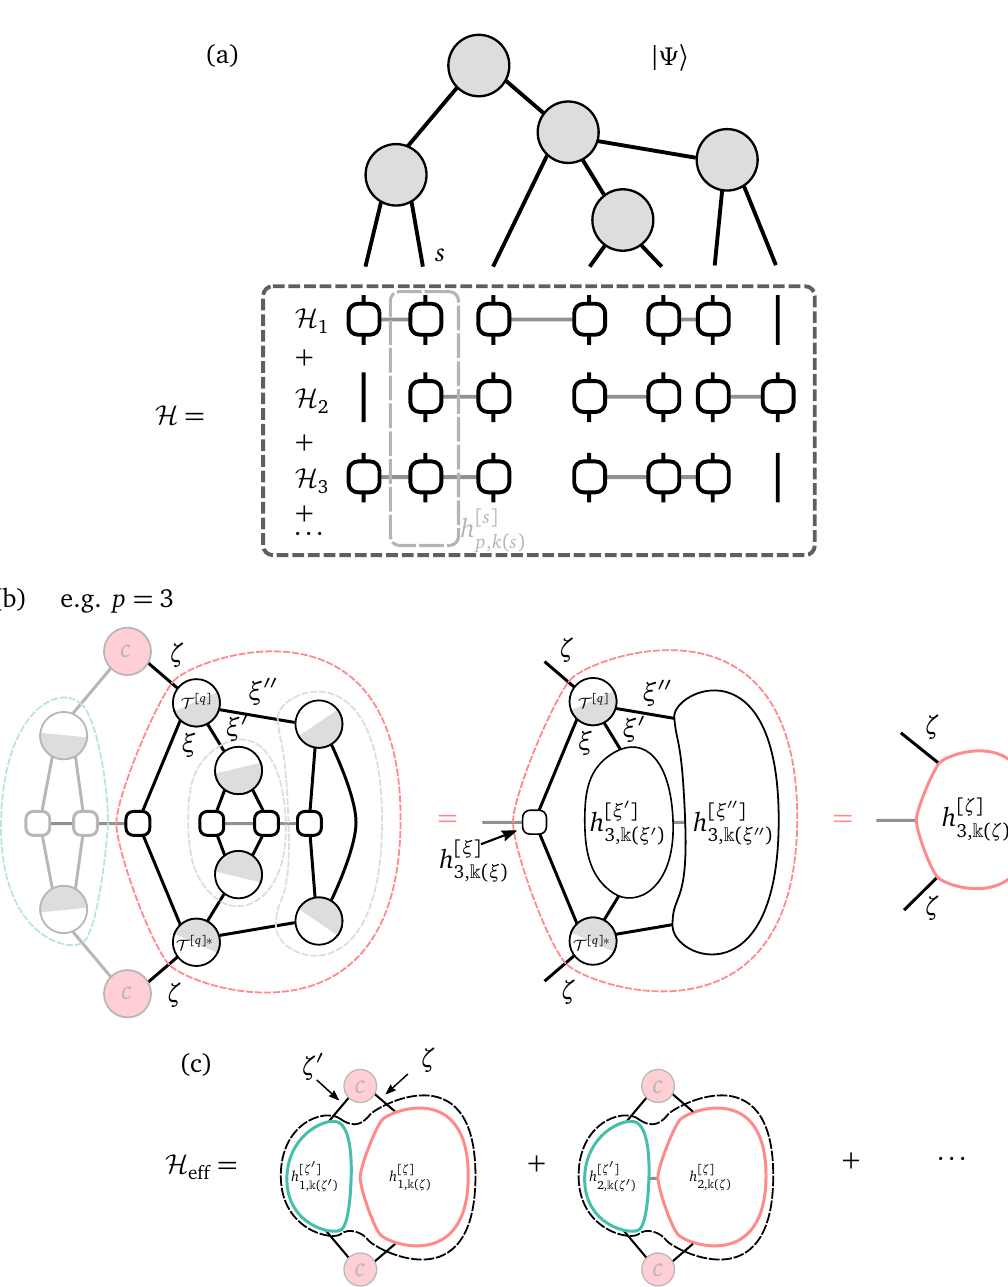
Figure 39: Example for the renormalization process that leads to the renormalized Hamiltonians: (a) The Hamiltonian H acting on the TN representation of some state | Ψ 〉 can be decomposed into TPOs H . (b) In a bottom-up approach, departing p from the state-tensors closest to the bare Hamiltonian tensors, we can build the [ η ] renormalized terms h on all links η below the chosen center c by iteratively p , k ( η ) contracting state tensors with the renormalized Hamiltonian terms of the previous level (dashed circles). (c) We can then determine the effective Hamiltonian H at eff the center node c by summing over the renormalized Hamiltonian terms acting on the links of c